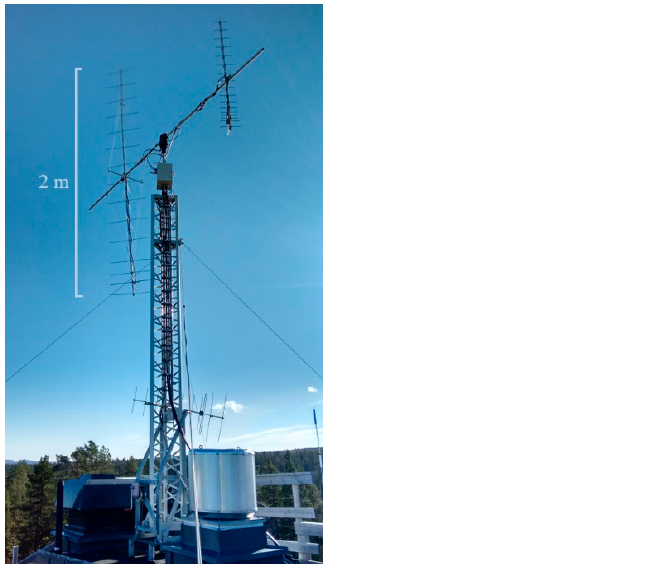
Figure 4. LTU’s ground station with one VHF (left) and one UHF (right) Yagi antenna in Kiruna, Sweden.